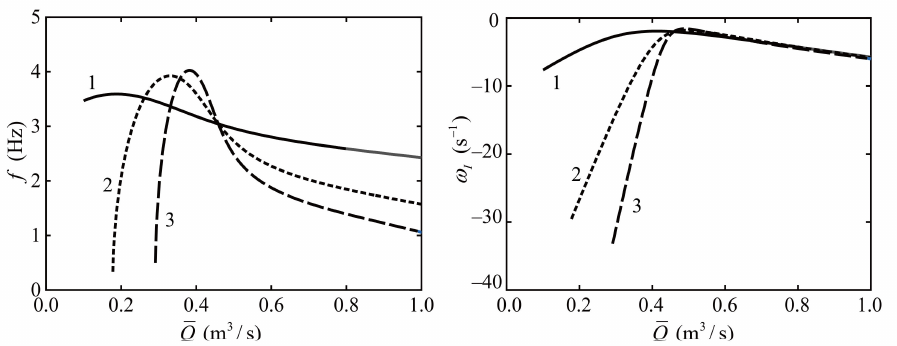
Figure 15. Frequencies ( left ) and increments ( right ) of the cavity oscillations. 1. α = 1; 2. α = 5; and 3. α = 10. C = 1.84 × 10 − 7 m 4 s 2 /kg is evaluated in accordance with recommendations from